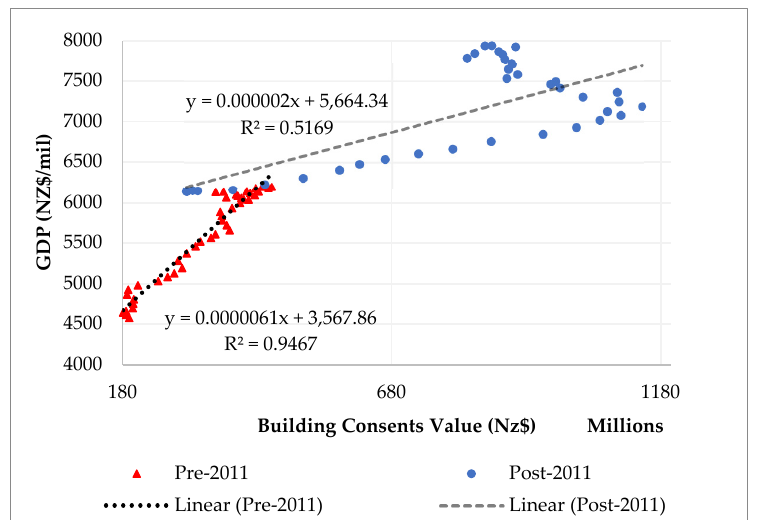
Figure 3. Association between building consent value and GDP value, Canterbury, Quarterly, 2000– 2020. Source : (StatsNZ 2021a) and author’s calculations.